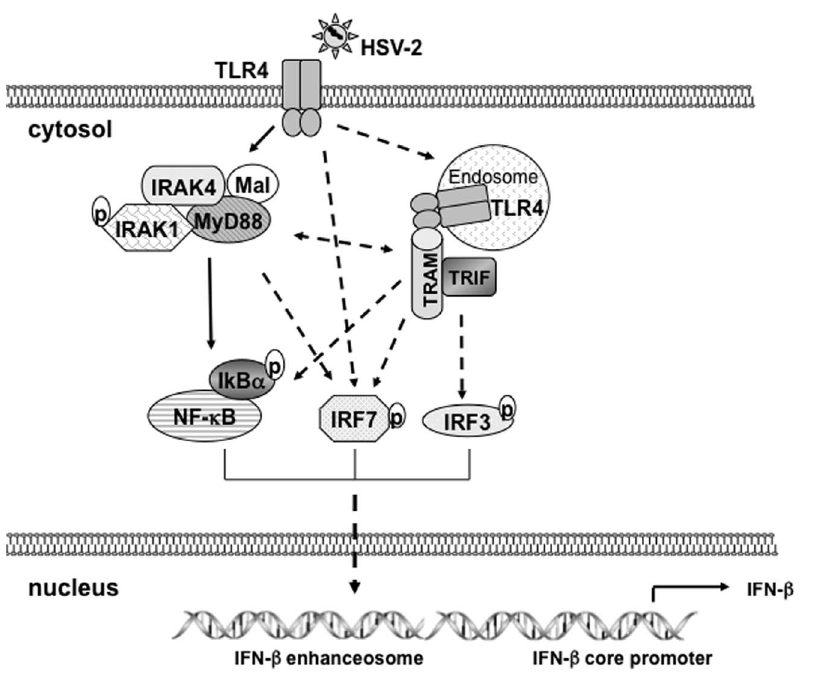
Figure 5. The proposed model that IRF3 and IRF7 are involved in TLR4-dependent induction of IFN- b by HSV-2 in HCE cells. HSV-2 infection induces TLR4 dependent signaling pathways. In addition to MyD88/Mal/IRAK1/NF-kB axis (data in submitted manuscript), adaptors molecules TRIF/TRAM may be activated following virus induced endocytosis. The key regulators IRF3 and IRF7 are phosphorylated and translocated into nucleus, thereby assembling the enhanceosome together with NF-kB and regulating the transcription activation of immediately downstream of IFN- b core promoter. The solid arrow lines represent the experiments confirmed signaling pathways. The dotted arrow lines represent the hypothetic signaling pathways.